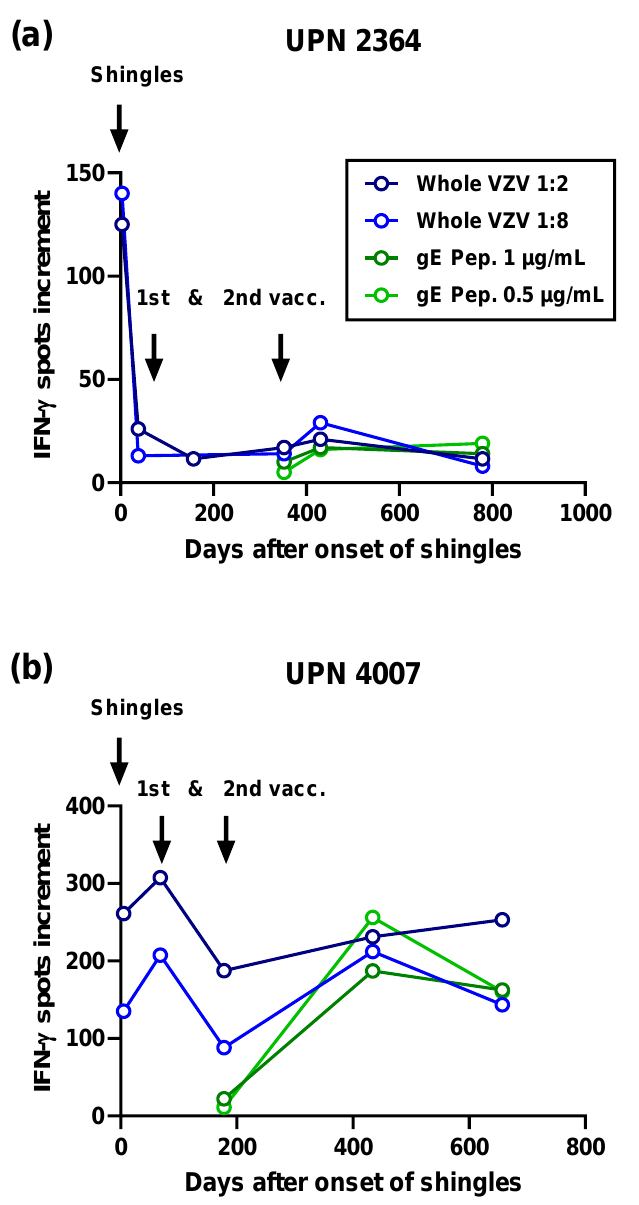
Figure 3. Courses of varicella-zoster virus-specific immunity in two hematopoietic stem cell trans- plant recipients tested already on day 3 ( a ) and day 5 ( b ) after the onset of shingles and in the follow-up after 1st and 2nd vaccination with the adjuvanted, recombinant zoster vaccine Shingrix™. The patients suffered from shingles 37 months ( a ) and 146 months (12 years) ( b ) after transplantation. Vacc-vaccination with Shingrix™; Whole VZV-whole varicella-zoster virus antigen (Behring, dilution 1:2 and 1:8); gE-peptide pool of glycoprotein E (JPT, 1 and 0.5 µg/mL per peptide).